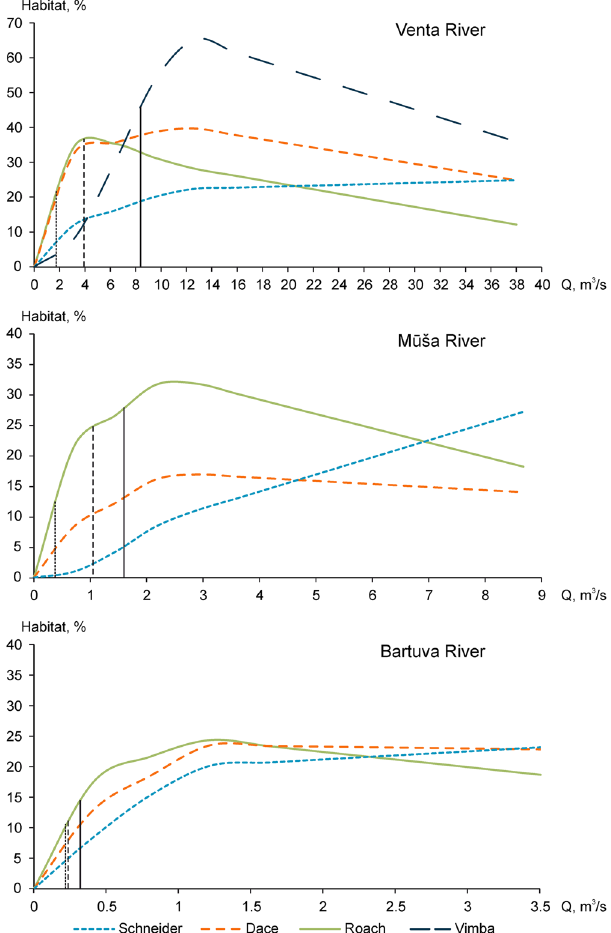
Figure 7. Habitat–flow rating curves for modelled fish species. The vertical axis represents habitat area (% of channel), and horizontal axis represents discharge (m 3 /s). The vertical solid line intersects the area of the habitat which is available for fish at Q 97 at natural conditions in a dry year, the dashed line intersects the average area that can effectively be used by fish in July–August during the operation of HPPs in a dry year, and the dotted line indicates the area of the habitat which is present at Q env